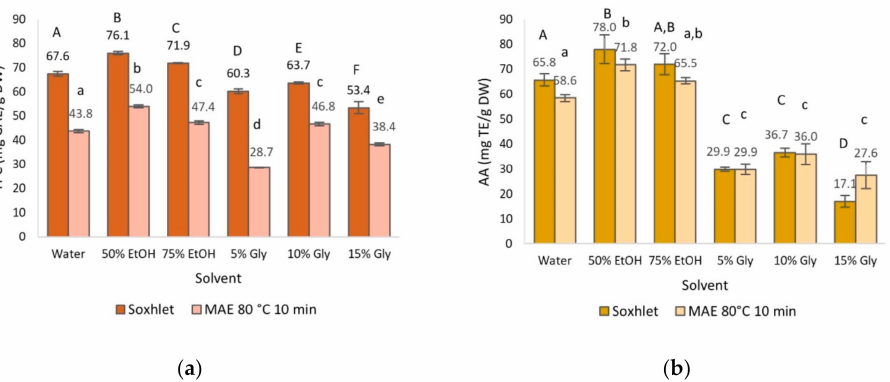
Figure 5. Comparison of ( a ) total phenol content (TPC) and ( b ) antioxidant activity (AA) of extracts obtained from Soxhlet and MAE at 80 ◦ C for 10 min. Different capital and lowercase letters above the bars represent groups significantly different at p < 0.05 by Soxhlet and MAE-10-80 methods,